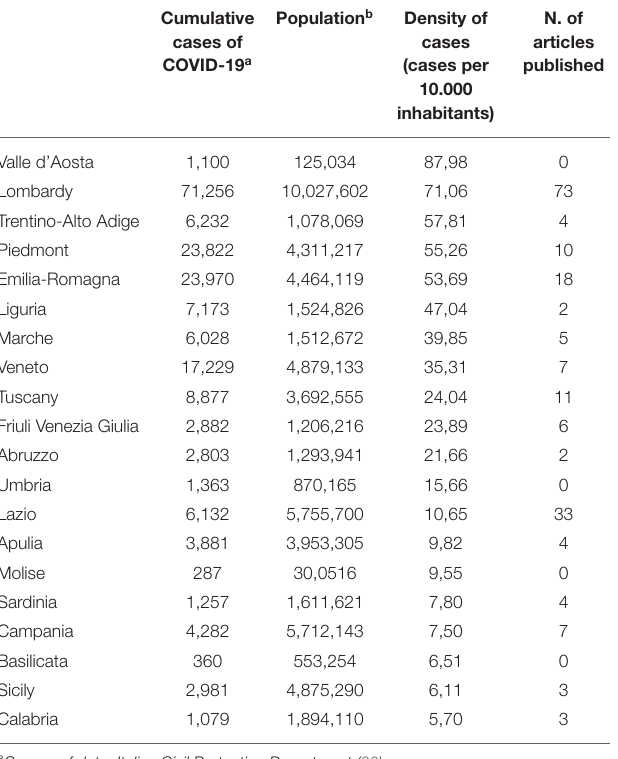
TABLE 2 | Geographical distribution of cases of COVID-19 and articles published up until 24 th April 2020. Regions are ordered by decreasing density of cases. Cumulative cases of